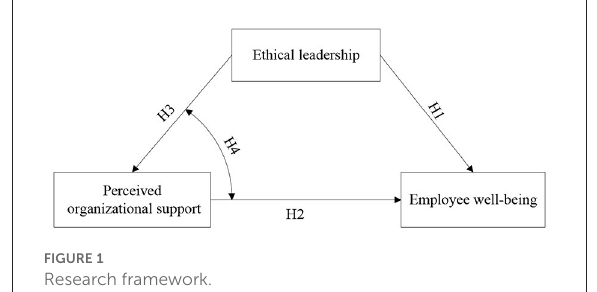
FIGURE1 Research